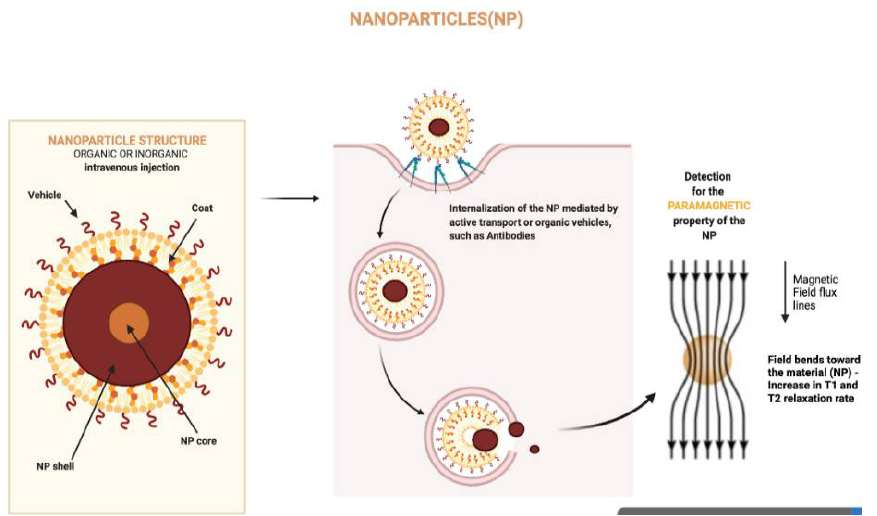
Figure 1. Nanoparticle structure and interaction with magnetic fields. The figure was created with BioRender.com.